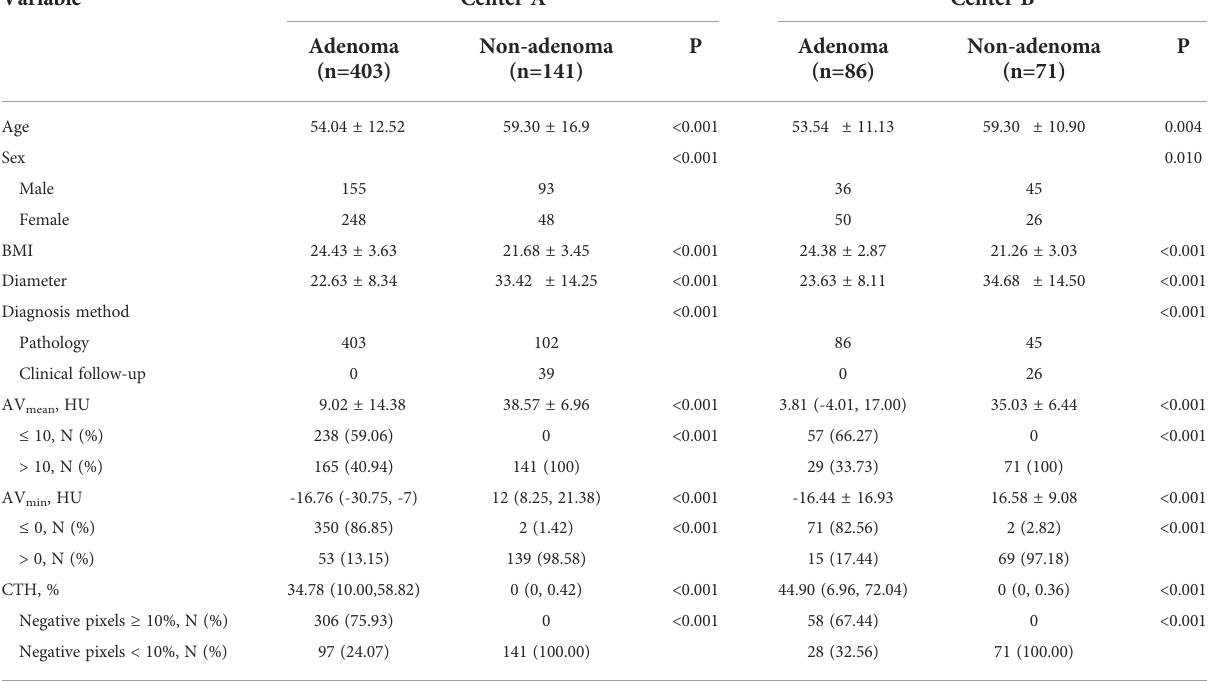
TABLE 1 Distribution of the three parameters in two centers.